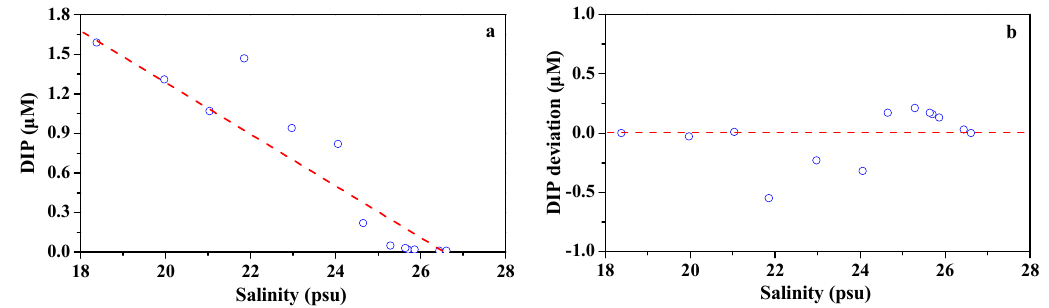
Figure 8. The DIP concentrations versus salinity in the surface waters from the lower Dafengjiang River to Qinzhou Bay. The dashed line denotes the theoretical mixing line between freshwater and seawater end members in the plot of DIP vs. salinity. The deviation of DIP represents the difference between the DIP concentrations forecasted based on the two-end-member mixing model and the ambient DIP concentrations. The dashed line denotes no deviation in DIP in the plot of DIP deviation vs. salinity. The positive and negative deviations indicate DIP drawdown by biological uptake and DIP addition, respectively.